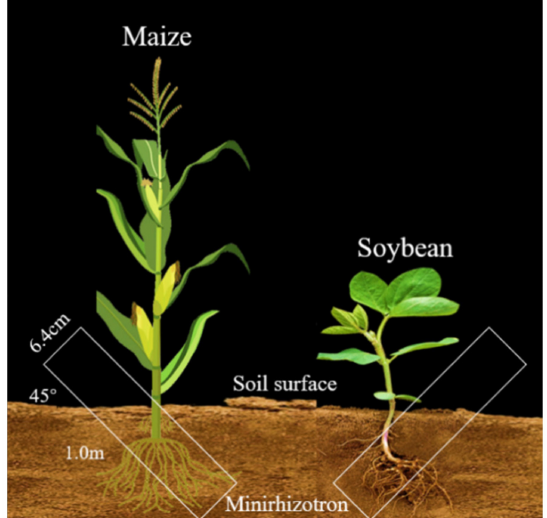
Figure 2. Schematic diagram of micro-root canal